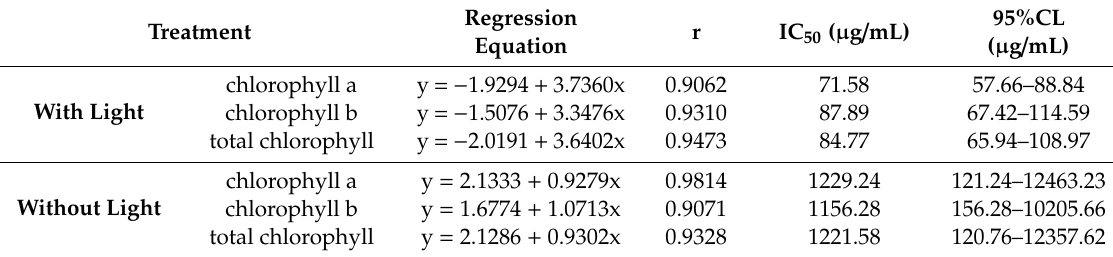
Table 3. IC 50 T. flousiana essential oil and Butachlor on the content of chlorophyll a, chlorophyll b, and total chlorophyll of S. communis with or without light (96 h).